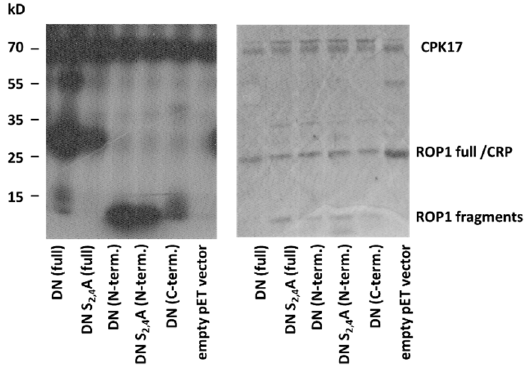
Figure 7. In vitro kinase assay using the CPK17 kinase and the DN mutant ROP1 GTPase either in full length, or its N- or C-terminal regions, respectively. The S2 and S4 residues were mutated (S2G S4A) to investigate the potential phosphorylation of the region that could not be detected by MS. Since an E. coli cAMP-activated global transcriptional regulator CRP (NCBI# 15803871, MW 23.8 kDa) co-purified with the 6xHIS ROP1 protein with about the same size, an empty vector control was included into the experiment.